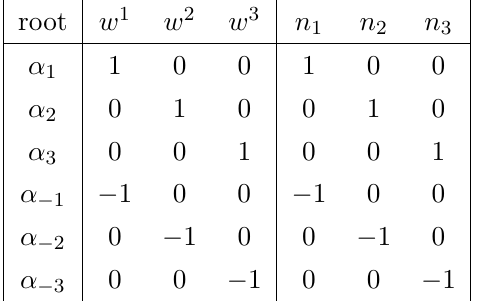
(cid:2) SU(2) 3 L R